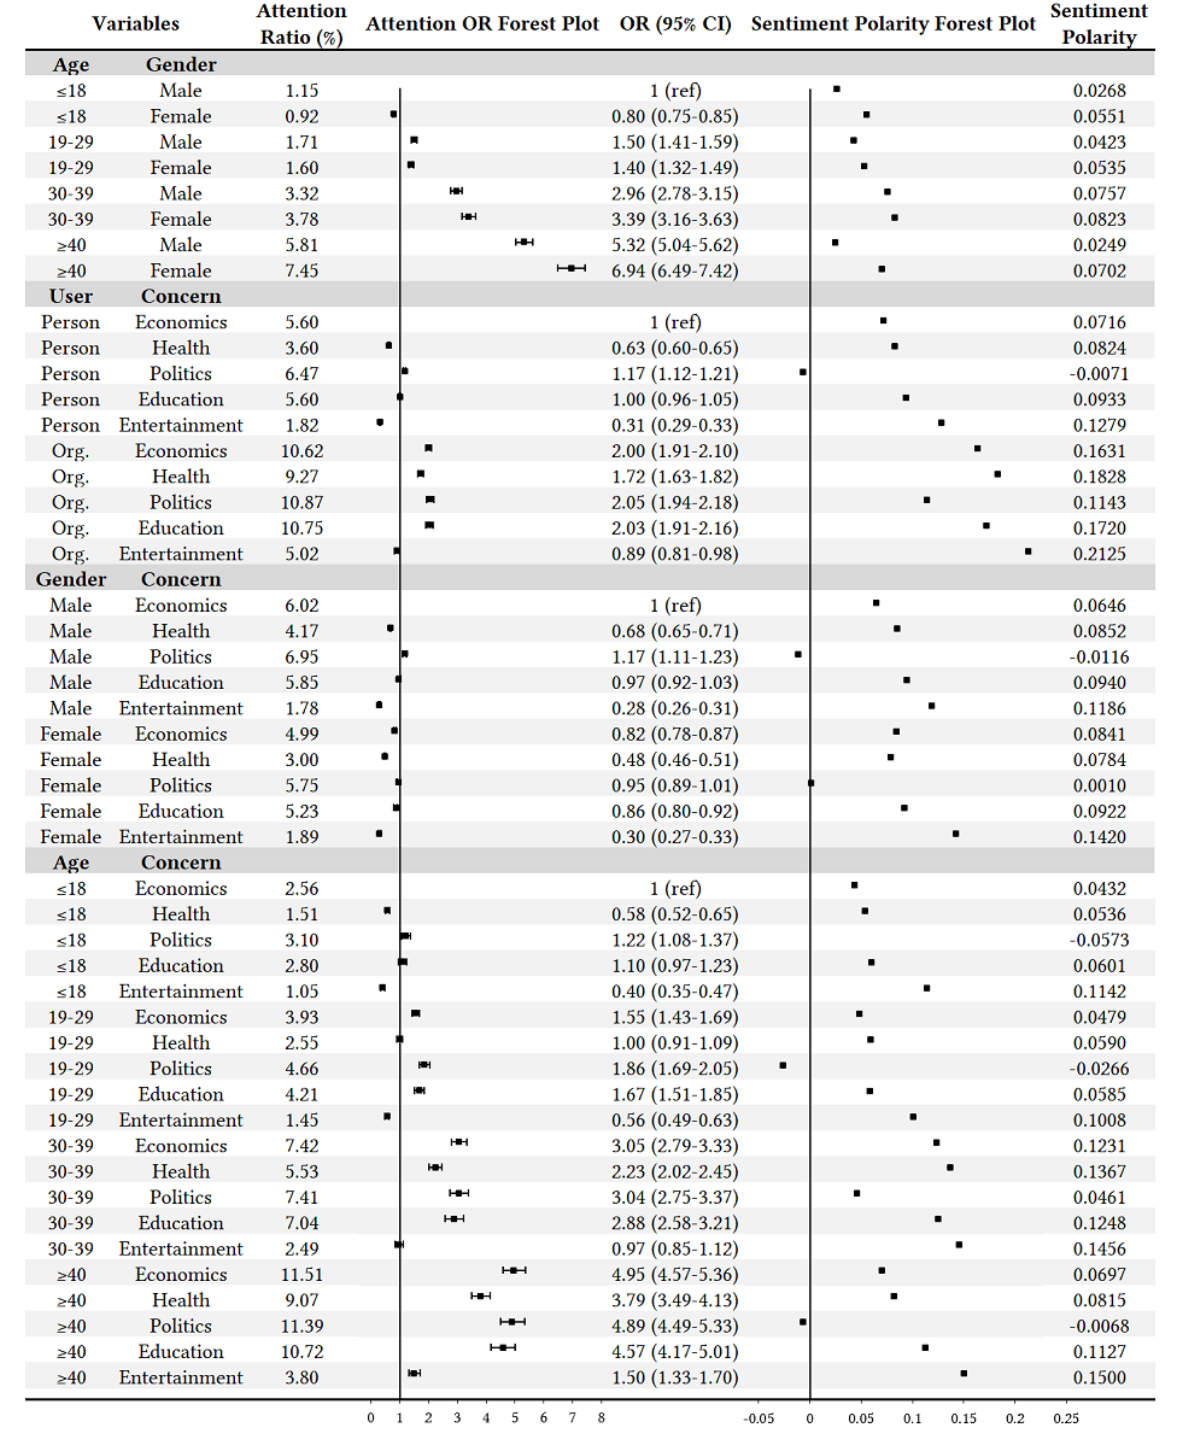
Figure 5. Bivariate analysis of COVID-19 concerns and sentiment polarities among different population groups. OR: odds ratio; Org: